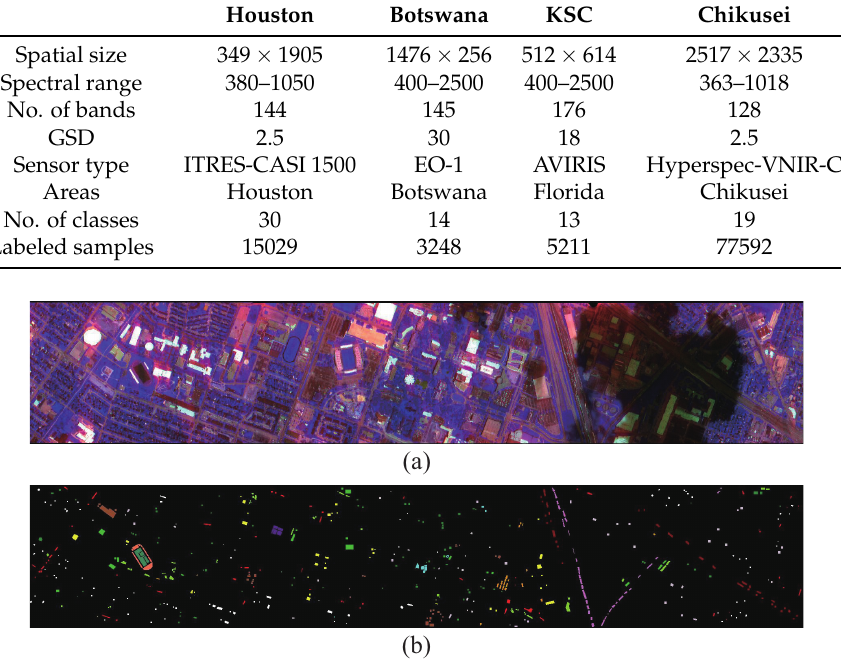
Figure 6. Houston data set. ( a ) Pseudocolor image. ( b ) Ground-truth map.